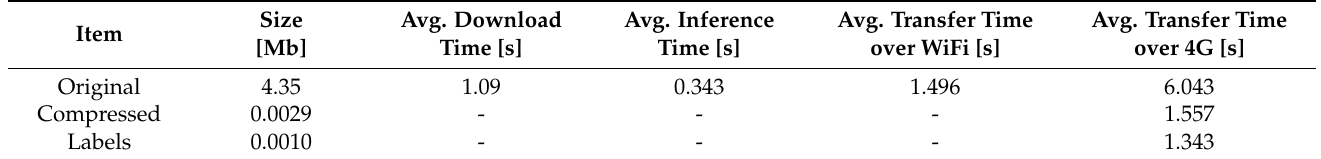
Table 2. Average inference and transfer times for various sized information objects over 4G LTE and